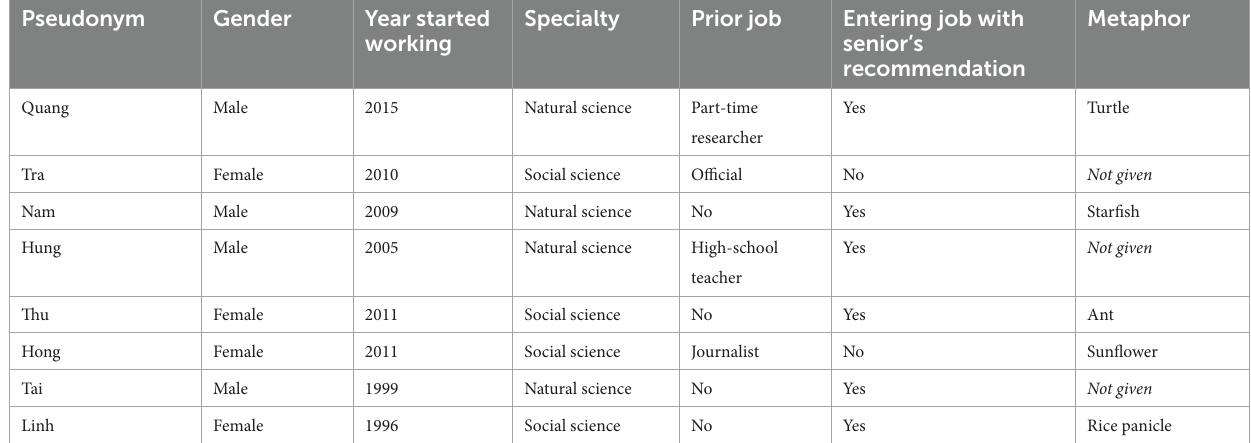
TABLE 1 Participants’ demographic information.